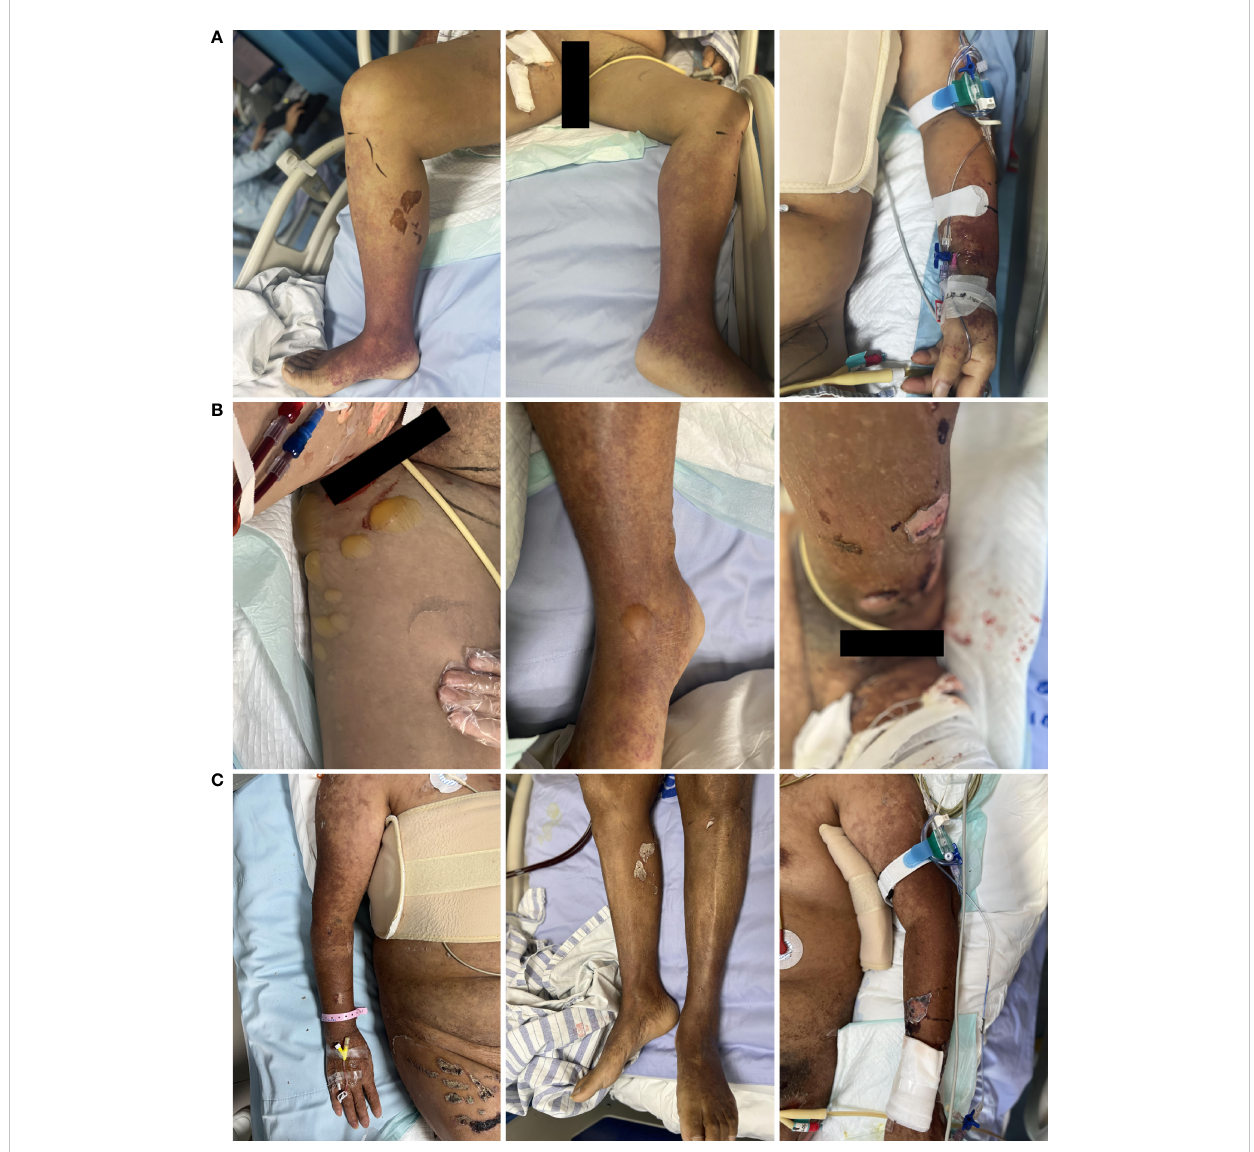
FIGURE 1 Evolution of the rash. (A) The early lesions were erythematous macules or papules approximately 1 to 5 mm in diameter that did not blanch on pressure. The erythematous maculopapular rash was mostly distributed on the arms and lower legs but was less distributed in the trunk. (B) The vesicles were pale or yellowish from serous fl uid matter. The vesicles slowly become enlarged and ruptured, leaving exuding areas. (C) Skin healing with